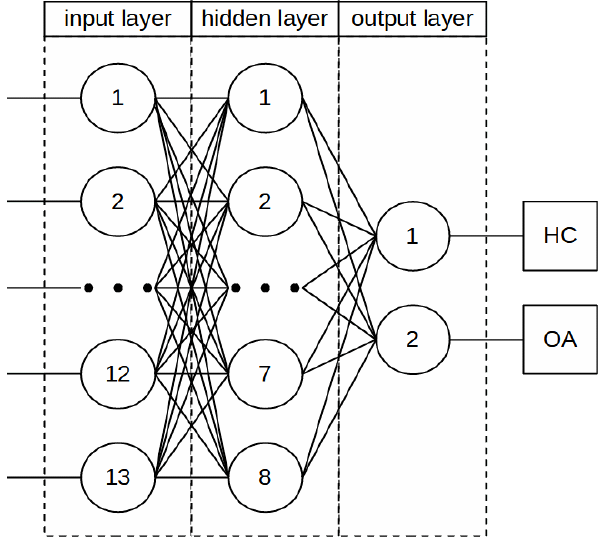
Figure 7. Graphical visualization of the applied neural network.